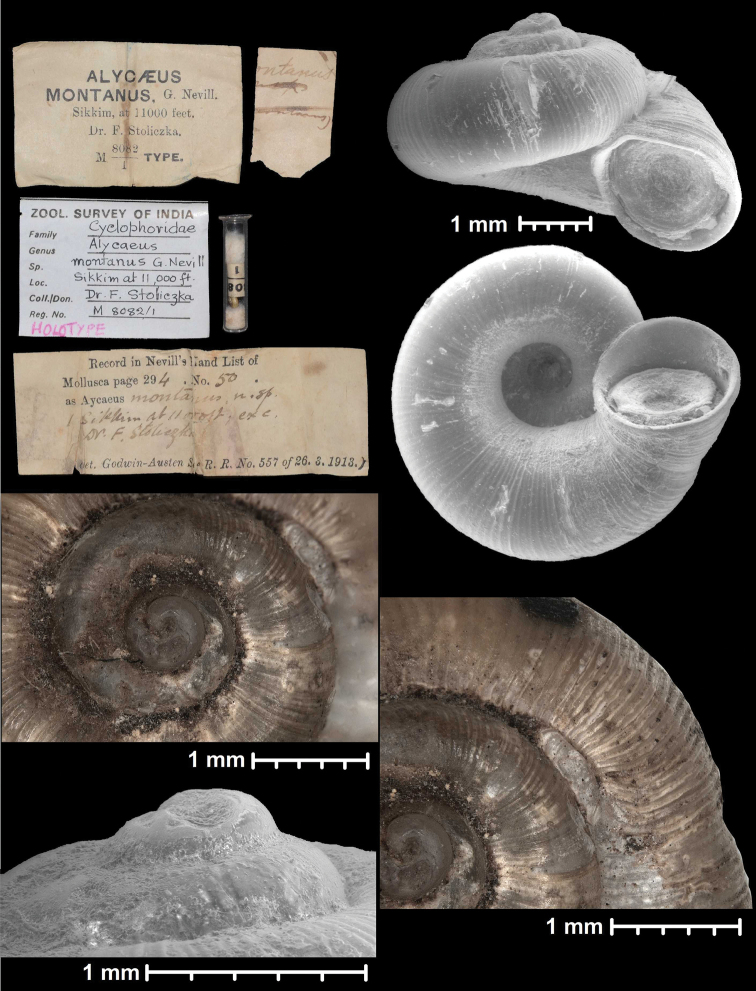
Dicharax
(?)
montanus (Nevill, 1881), syntype (NZSI M.8082). All images: Sheikh Sajan.